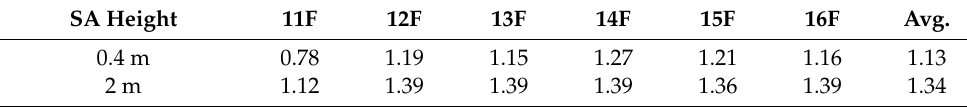
Table 9. PMV value for each floor with varying SA